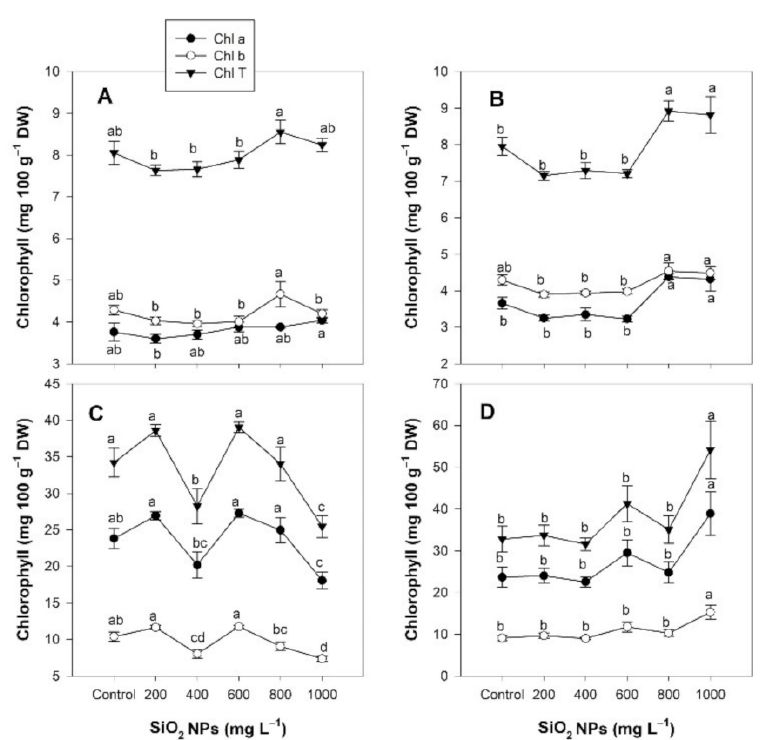
Figure 3. Effect of the application of SiO 2 NPs via the soil method ( A , C ) and the foliar method ( B , D ) on the concentration of chlorophyll in the flowers ( A , B ) and leaves ( C , D ) of Lilium . Different letters indicate significant differences according to Fisher’s least significant difference test ( p ≤